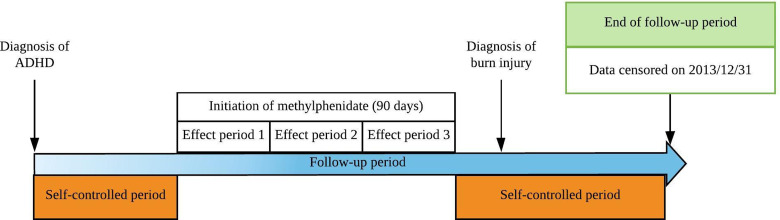
Overview of the self-controlled case series study design. The self-controlled case series study design was used in this study for within-patient comparisons to examine the effect of methylphenidate on traumatic brain injury in adolescent patients with ADHD. The effect period for methylphenidate is set at 1–3 months. Thus, the effect period was split into three 1-month effect periods: 0–30, 31–60 and 61–90 days at the end of each treatment period. Individual's time not within the treatment period would serve as a self-controlled period for self-comparison. Time point of cohort entry was defined as the date of age of onset of ADHD. The end of follow-up was 31 December 2013.